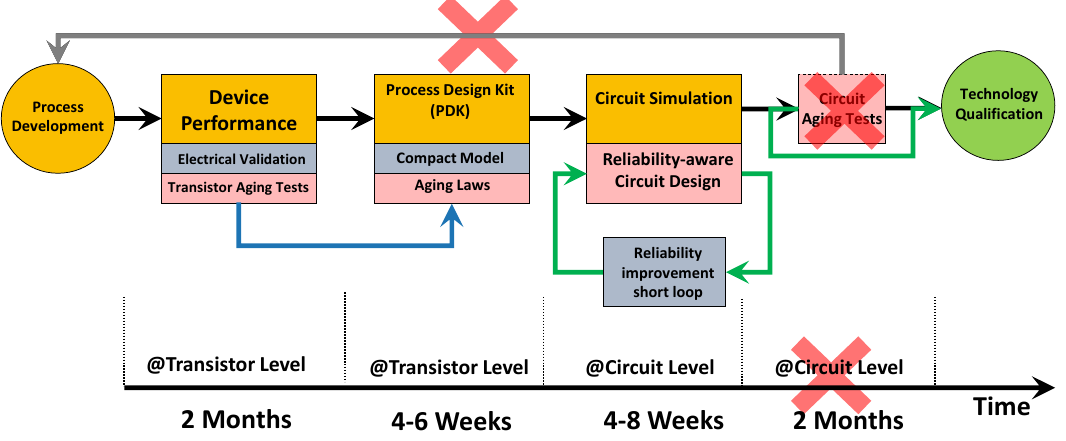
Figure 23. Methodology flow illustrating the reliability improvement loop.